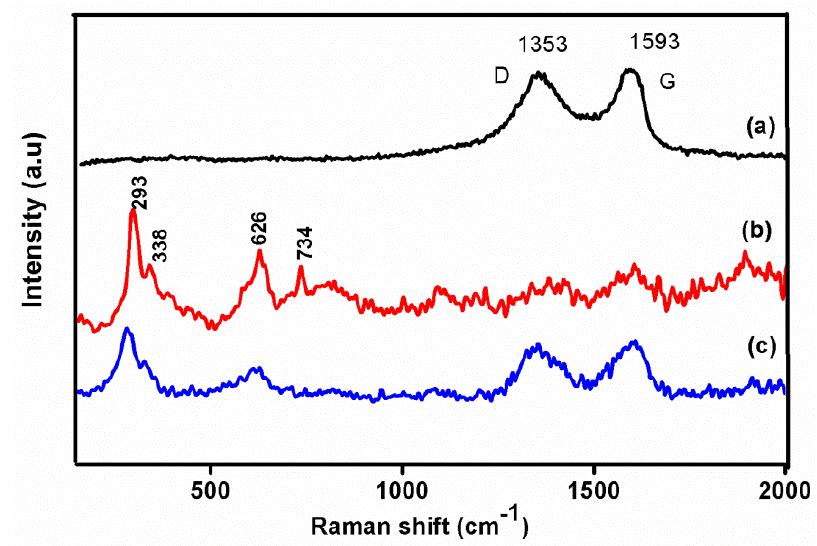
Figure 3. Confocal Raman spectra of ( a ) GO, ( b ) Cu 2 O, and ( c ) GCC